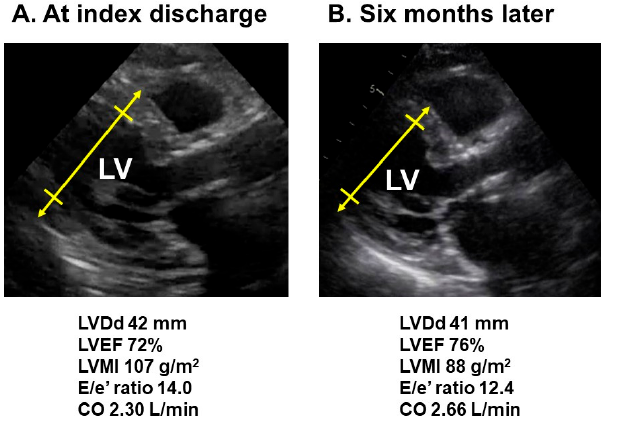
Figure 2. Long-axis views of transthoracic echocardiography obtained at index discharge ( A ) and six-month follow-up ( B ); LV, left ventricle; LVDd, left ventricular end-diastolic diameter; LVEF, left ventricular ejection fraction; LVMI, left ventricular mass index; CO, cardiac output.